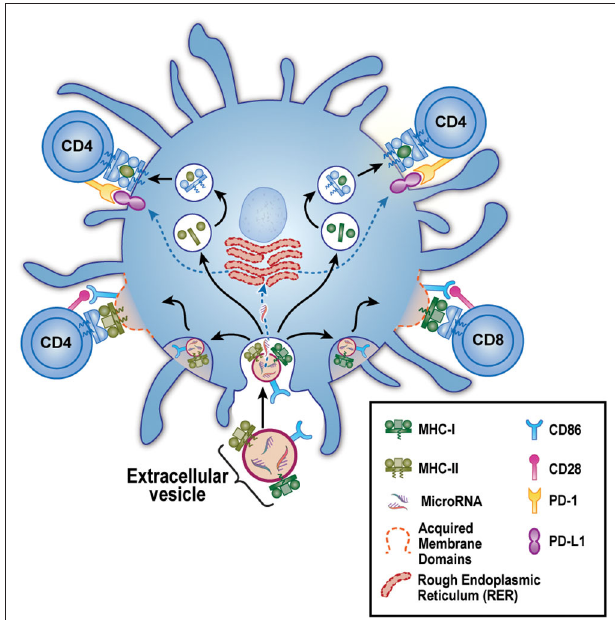
FIGURE 1 | Model for EV-Associated Dendritic Cell “split” tolerance. An extracellular vesicle (EV) derived from maternal micro-chimerism [or from certain allograft types] is taken up by a host dendritic cell (blue). These EV contain microRNA and express surface membrane-bound allo-MHC class I (green) and II (olive), along with the co-stimulatory molecule CD86. After uptake, the microRNA escape to the endoplasmic reticulum where they guide production of PD-L1 (purple). The allo-class I and class II are either (bottom) preserved intact and re-distributed as components of acquired membrane domains (dashed red lines) containing CD86, or (top) broken down in lysosomal vesicles to peptides that are loaded onto “self” MHC class II. These 2 forms of allo-antigen presentation, semi-direct (lower left and right), and indirect (upper left and right) are kept separate by the host DC, allowing positive co-stimulation of semi-direct pathway, allo-specific host CD4 and CD8T cells via CD86-CD28 (pink) interaction. Yet even as these productive interactions are occurring, the CD4T helper cells are being strongly inhibited by PD1 (yellow) interaction with the negative co-stimulator PD-L1. The net result is limited acute rejection in the short term, followed by long-term protection of the allograft from chronic rejection (“split”